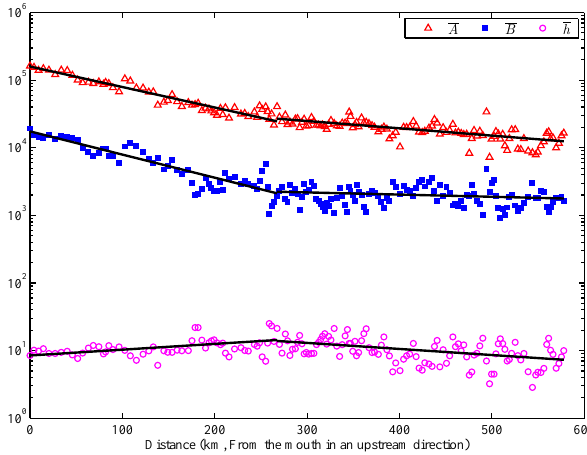
Figure 4. Semi-logarithmic plot of the tidally averaged cross- sectional area A (triangles), width B (squares) and depth h (circles) in the Yangtze estuary. The drawn lines represent the fitted expo- nential